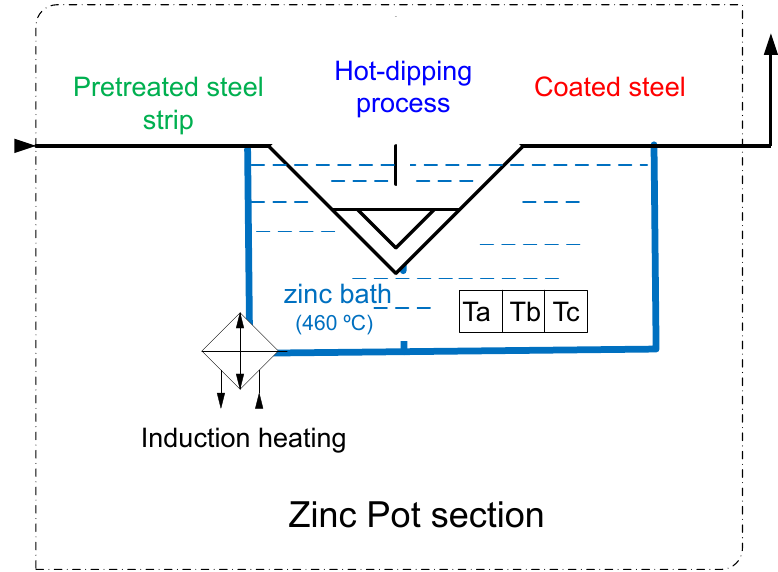
Figure 2. Galvanizing section (hot dip zinc bath). Pretreated steel goes into the zinc pot, which is filled with an Al–Zn solution at 460 ◦ C. Thermocouples Ta, Tb and Tc measure the local temperatures